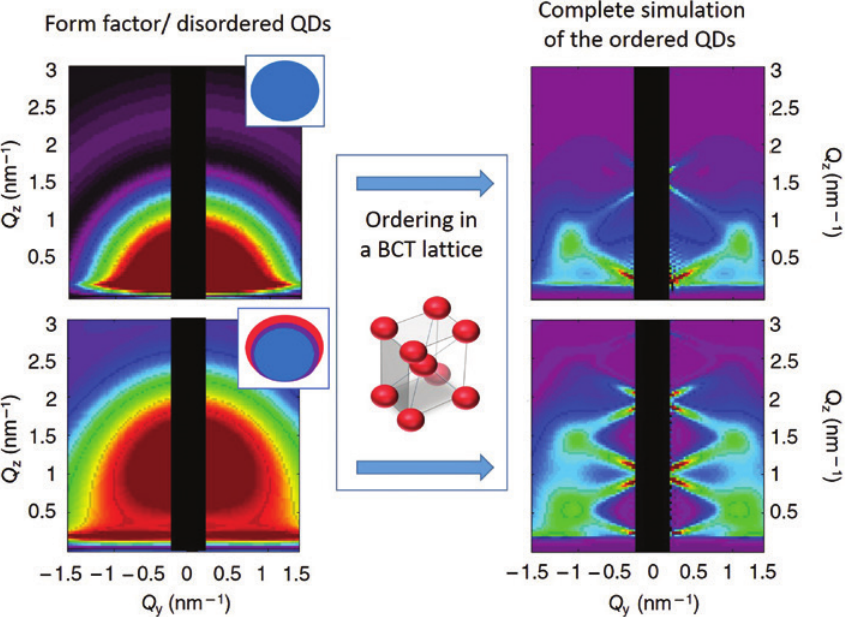
Figure 3: Simulations of GISAXS maps for simple (just core) and core/shell QDs having fully disordered and BCT regular arrangement. For a completely disordered QD system (left column), the structure factor is constant and GISAXS maps are dominated by the form factor contribution only. By ordering QDs in a BCT lattice (right column), there is a contribution from both the structure and the form factor, result- ing in the simulations shown in the right side of the figure. A clearly different image for the core/shell and only core QDs of the same size is shown, thus giving us the powerful tool of showing that a core/shell structure is obtained.